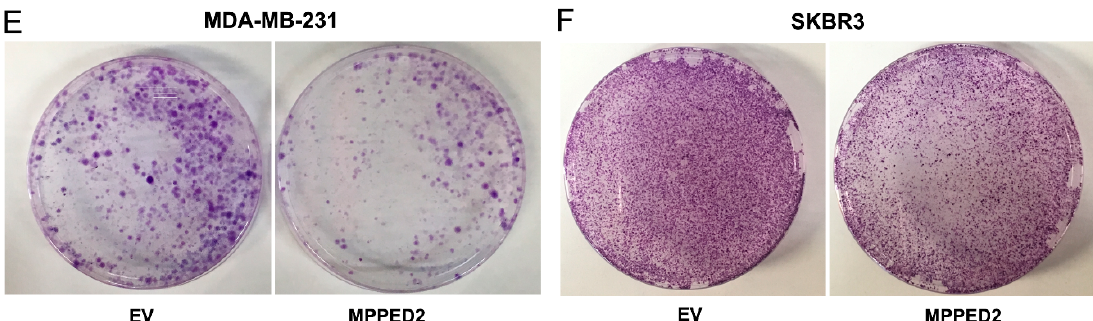
Figure 5. MPPED2 reduces cell proliferation of breast carcinoma cell lines. ( A , B ) qRT-PCR (left panel) performed in MDA-MB-231 and SKBR3 cells stably expressing MPPED2 or carrying the corresponding empty vector (EV). Data are reported as 2 − ∆∆ Ct values ± SD, compared to the EV, set equal to 1. Western bot (right panel) analysis confirming the expression of MPPED2. β -actin was used to normalize the amount of loaded protein (left panel). Densitometric analysis was performed by using ImageJ software to evaluate MPPED2 protein expression compared to EV, set equal to 1. Original blots were shown in Supplementary Materials Figure S5. ( C , D ) Cell growth analysis of MDA-MB-231 and SKBR3 cells stably expressing MPPED2 or carrying the corresponding empty vector (EV). Cell number was evaluated at 24 h, 48 h, 72 h and 96h after seeding. Values were obtained from three independent experiments performed in duplicate. Data are reported as mean ± SD. 2-way ANOVA test (Bonferroni post-test: MPPED2 vs. EV, 96 h and 72 h, ***, p < 0.001). ( E , F ) Representative colony assays performed in MDA-MB-231 and SKBR3 cells transiently transfected with MPPED2 or the corresponding empty vector (EV). Cell were stained with crystal violet after 3 weeks of selection with